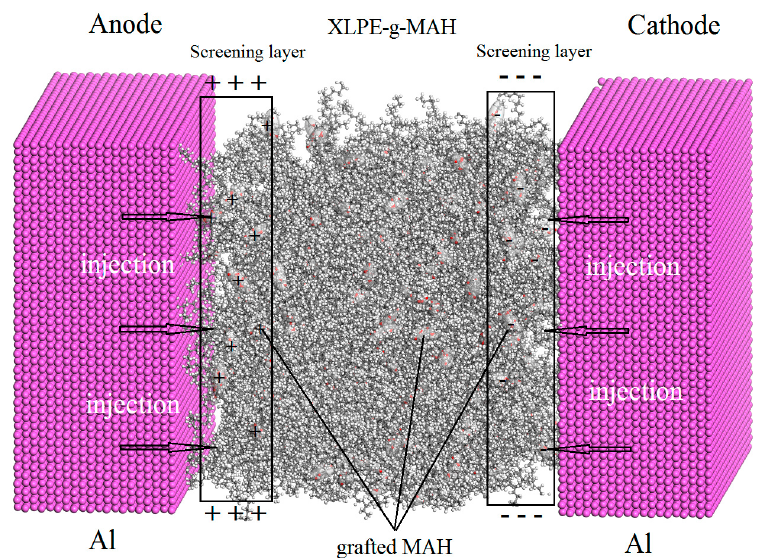
Figure 6. Schematic Coulomb-potential screening mechanism of suppressing space charge accumulation inside XLPE-g-MAH under DC electric field.